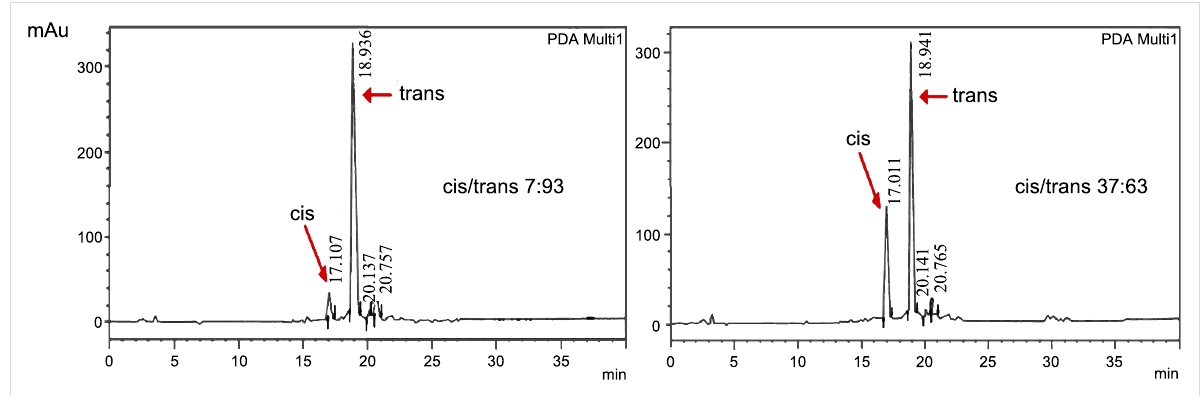
Figure 2: HPLC quantification of the cis / trans ratio of AZO-CDim 1 before irradiation (left) and after irradiation at 365 nm (2 h, 6 W lamp) (right).